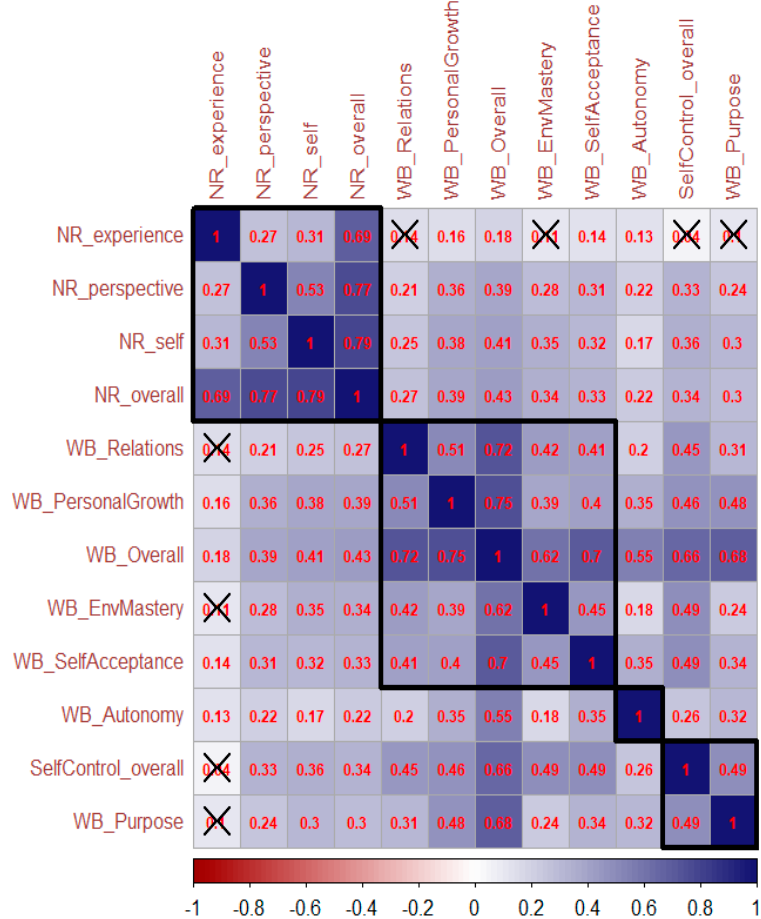
Figure 3. Correlation coefficients for Nature Relatedness and Psychological Well Being (men).